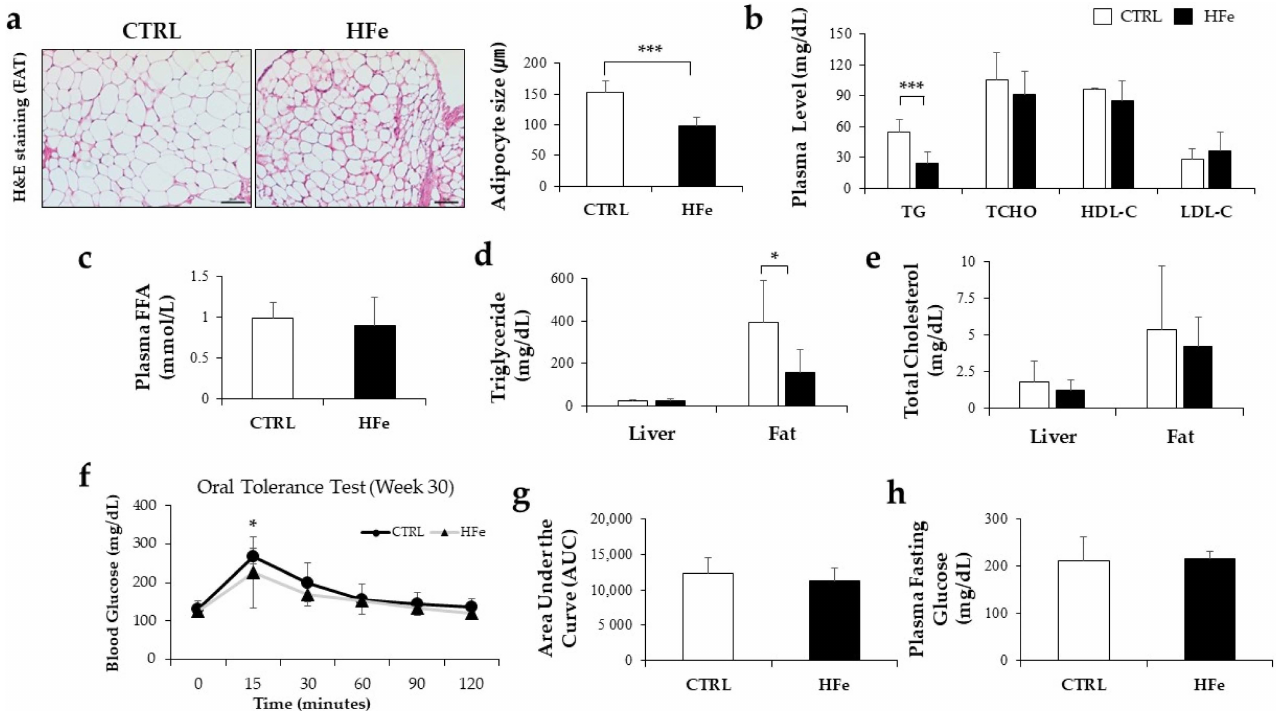
Figure 4. HFe decreased the adipocyte size and TG levels in the blood and fat tissues. Represen- tative images of hematoxylin and eosin (H&E) staining. ( a ) Decreased adipocyte size in HFe mice. ( b ) Plasma biochemistry related to lipid profiles and ( c ) FFA were measured at week 30. ( d ) TG and ( e ) TCHO levels in liver and fat of each group. ( f ) The results of OGTT, ( g ) AUC of OGTT, and ( h ) plasma fasting glucose at week 30 in mice fed CTRL and HFe diet. Data are expressed as means ± SE; Student’s t test was used to test differences between means. * p < 0.05, *** p < 0.001. TG, triglycerides; TCHO, total cholesterol; HDL-C, high-density lipoprotein cholesterol; LDL-C, low-density lipoprotein cholesterol; FFA, free fatty